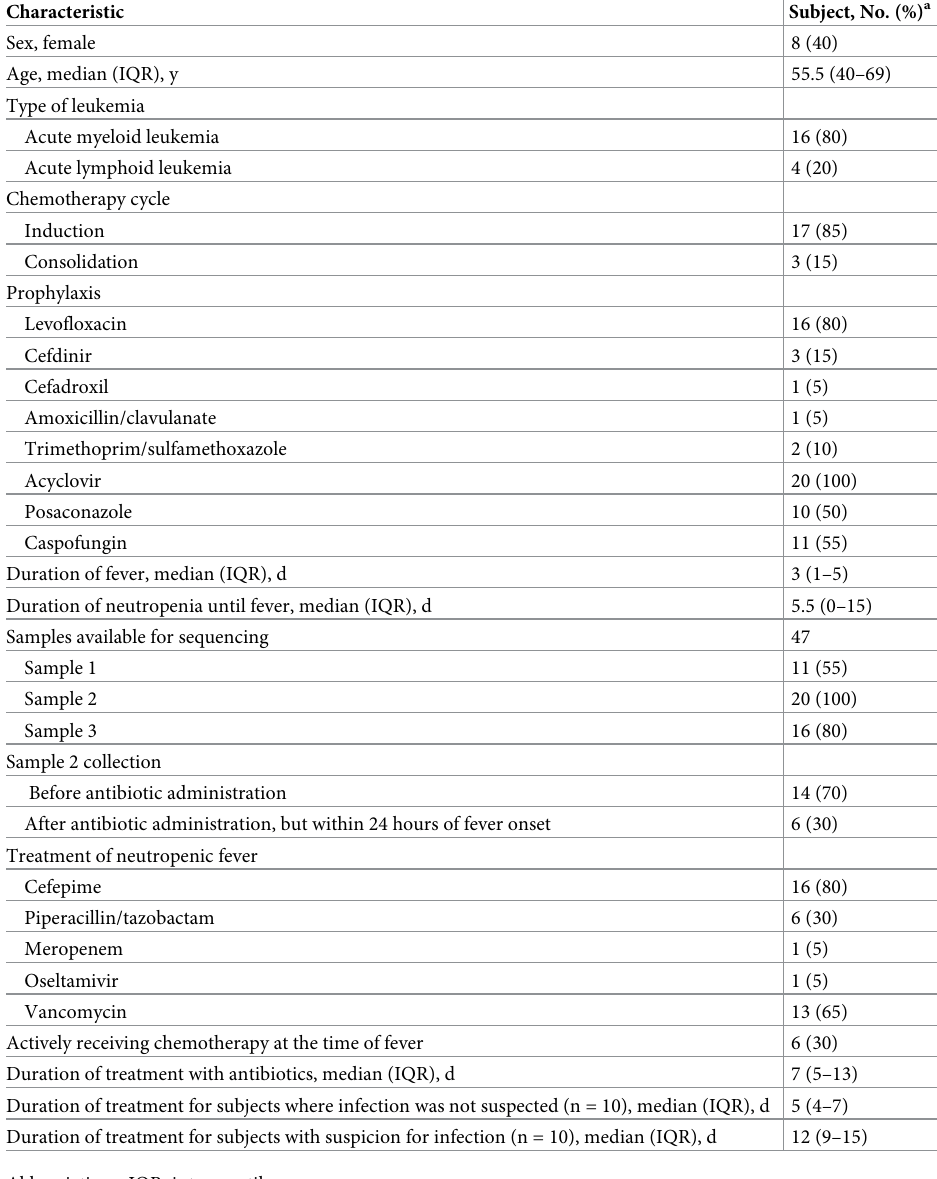
Abbreviations: IQR, interquartile range.